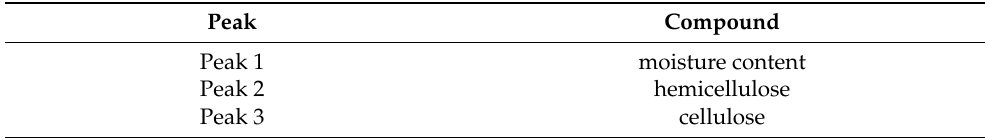
Figure 5. DSC curves for kenaf fiber with NaOH treatment and without NaOH treatment. Table 3. DSC result for kenaf